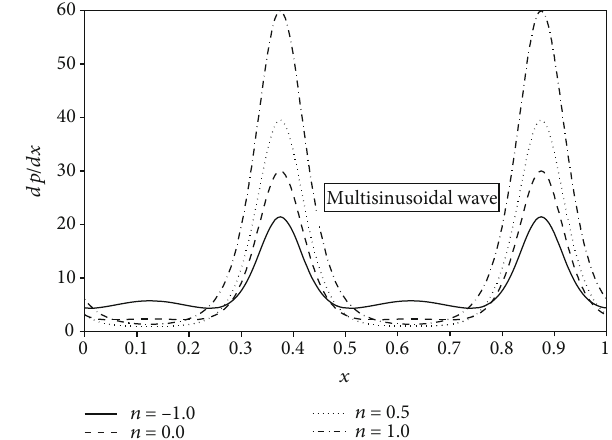
Figure 9: Variation of pressure gradient with x for di ff erent values of n for fi xed values of φ = 0 : 5 , β = 4 , We = 0 : 6 , and Q = − 2